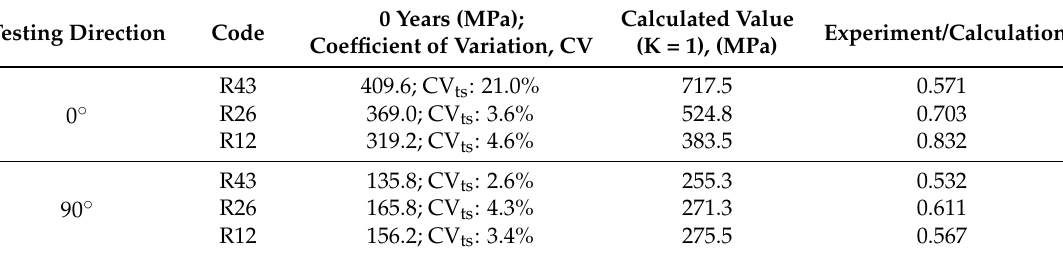
Table 3. Tensile strength of unpainted specimens in comparison with calculated values.